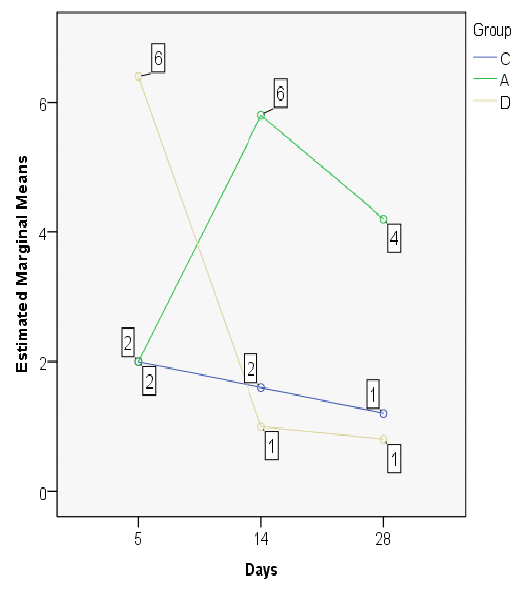
Figure 17. Goblet cell count, MANOVA Test.